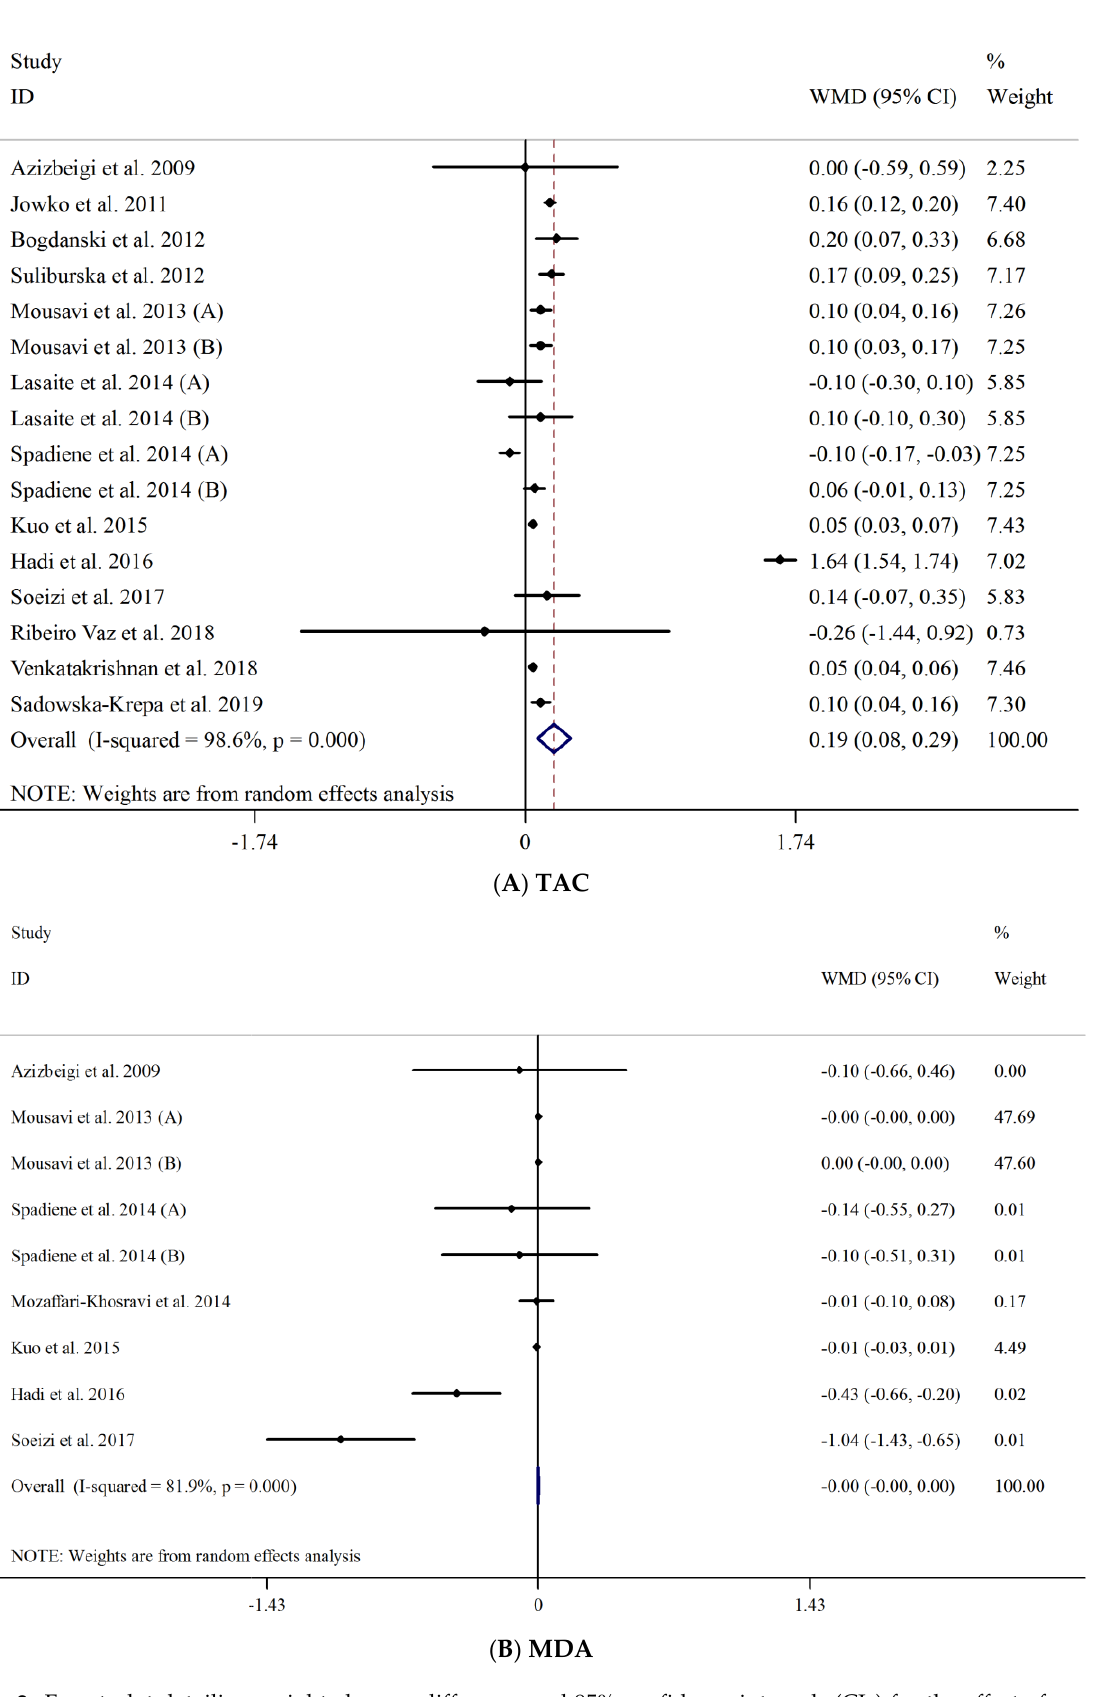
Figure 2. Forest plot detailing weighted mean difference and 95% confidence intervals (CIs) for the effect of green tea consumption on; ( A ) TAC; ( B ) MDA.